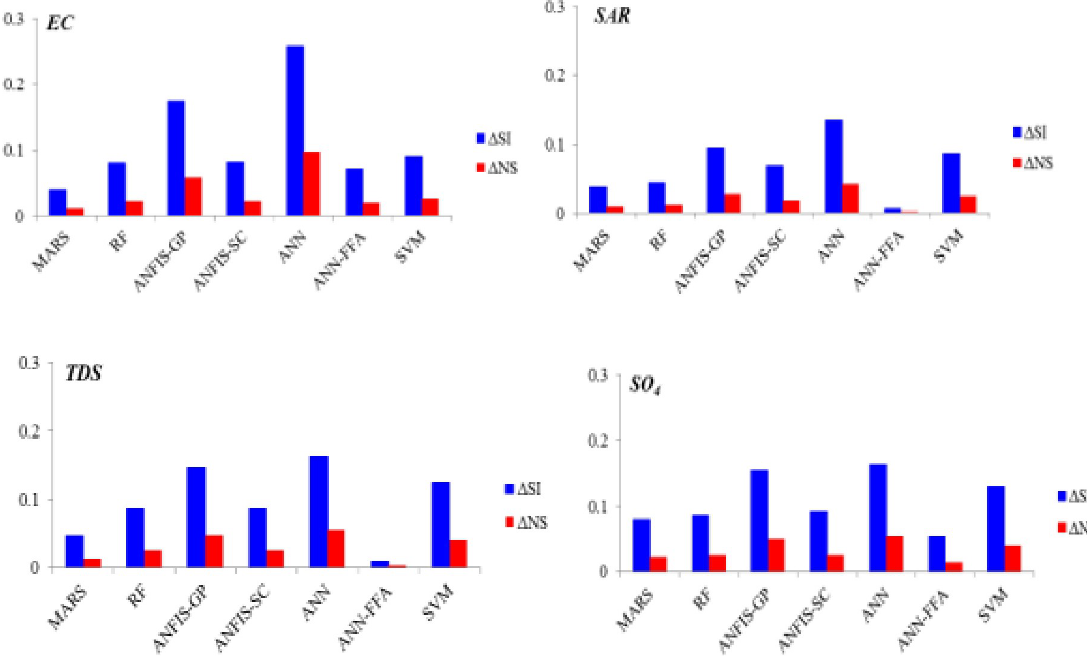
Fig 5. Improvements obtained through using SVM-FFA model by the second scenario in terms of SI reduction and NS increase.